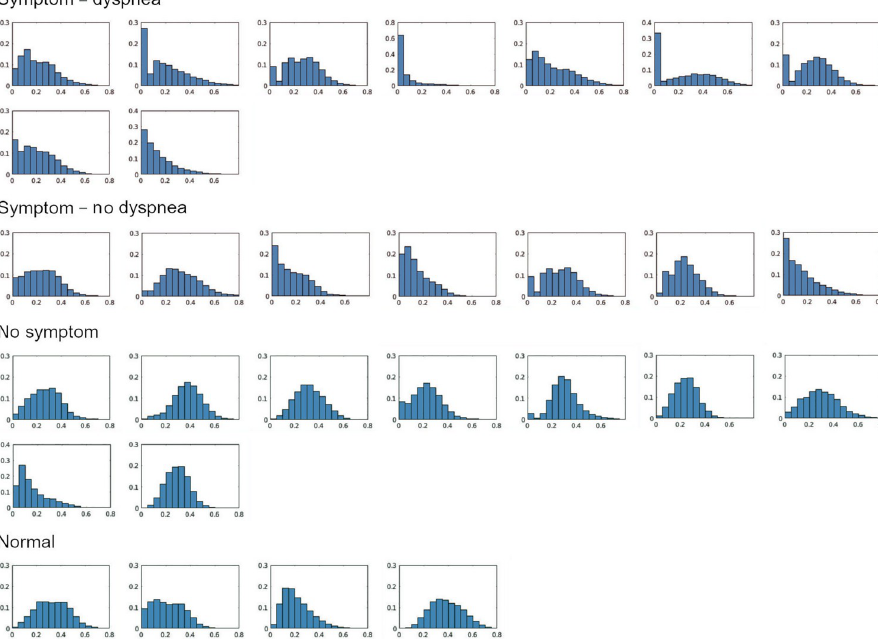
Fig 4. Lung ventilation distribution in normal, asymptomatic, symptomatic without dyspnea and with dyspnea cases.